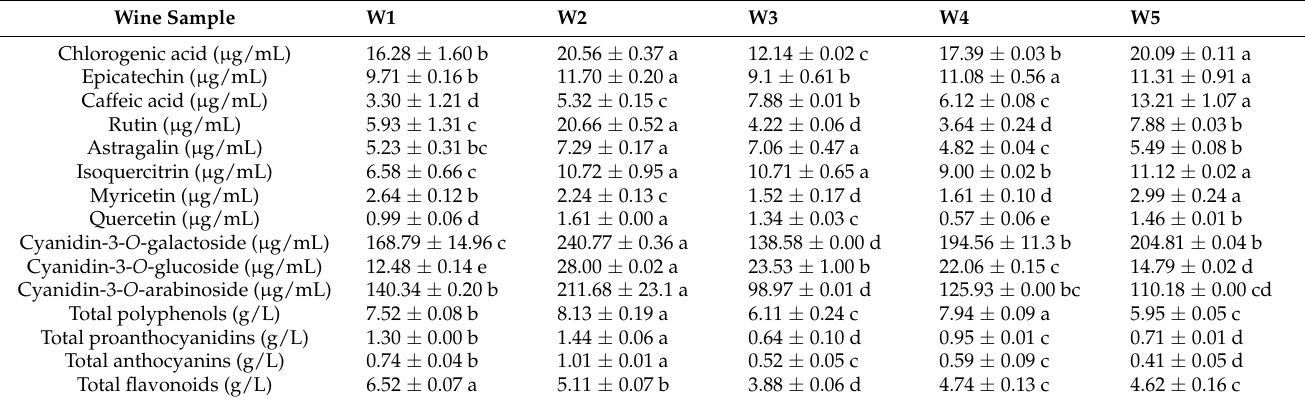
Table 4. Phenolic contents in the black chokeberry wines made by different brewing